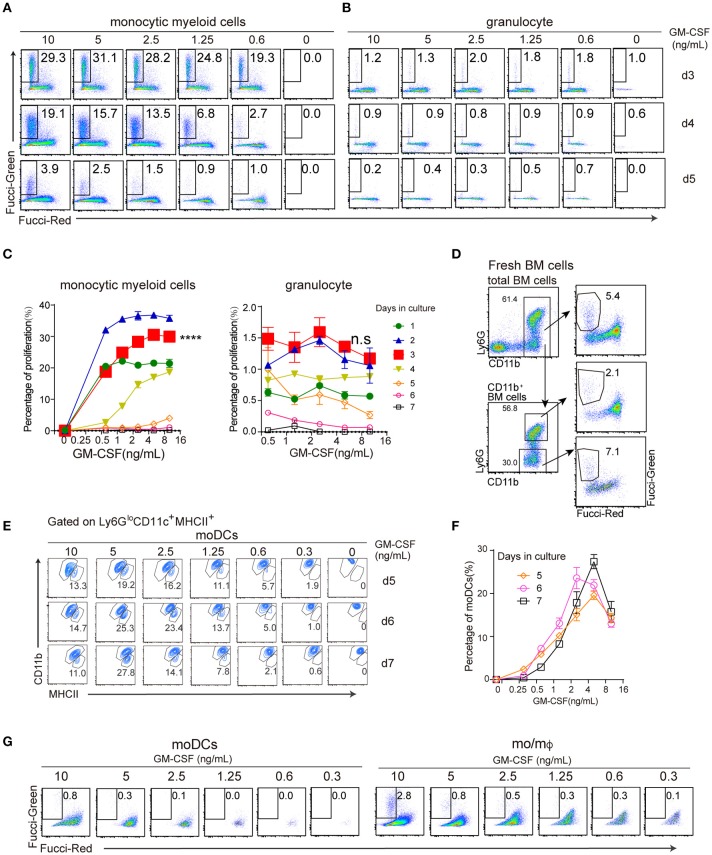
The effect of GM-CSF dose on the proliferation of monocytic myeloid cells and granulocytes. (A,B) FACS plots show profiles of FucciGreen+ Red− proliferating cells of monocytic myeloid cells and granulocytes with different doses of GM-CSF from day3 to day5. (C) Plots show the percentage of proliferation of monocytic myeloid cells and granulocytes with different doses of GM-CSF from day1 to day7. ****p < 0.0001 (ANOVA). (D) Plots show BM cells prior to culture. (E) Gated on CD11c+MHCII+, FACS plots show profiles of MHCIIintermCD11bhi mo/mΦ and MHCIIhiCD11binterm moDCs with different doses of GM-CSF from day 5 to day 7. (F) Plots show the percentage of moDCs under different GM-CSF dose stimulation from day 5 to day 7. (G) FACS plots show profiles of proliferating cells of moDCs and mo/mΦ with different doses of GM-CSF on day5.